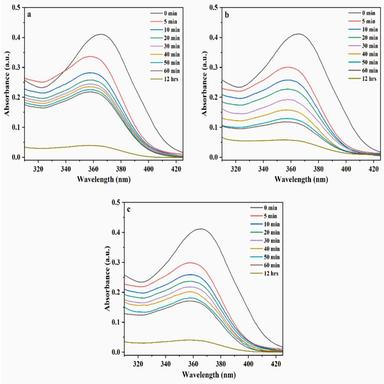
UV–Vis spectra of adsorption of TTC antibiotic onto (a) Ti-TPA-Si, (b) Ti-TPA-Si-C, and (c) Ti-TPA-Si-CS.